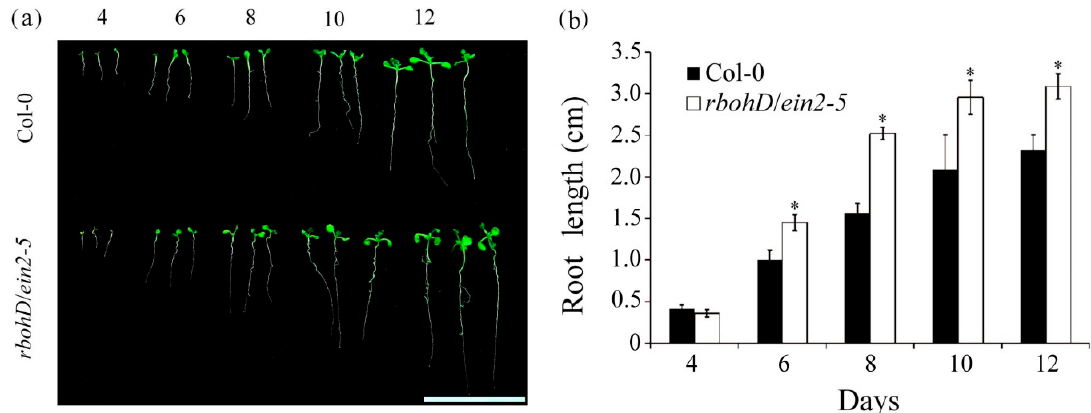
Figure3. Comparisonofrootgrowthinwild-typeand rbohD / ein2-5 doublemutantseedlings. ( a )Phenotypes Figure 3 . Comparison of root growth in wild ‐ type and rbohD / ein2 ‐ 5 double mutant seedlings. ( a ) of seedlings grown on 1 / 2 MS medium for 4, 6, 8, 10, and 12 d. Bar = 2 cm. ( b ) Average root length of Phenotypes of seedlings grown on 1/2 MS medium for 4, 6, 8, 10, and 12 d. Bar = 2 cm. ( b ) Average seedlings grown on 1 / 2 MS. Error bars represent SD of 100 seedlings of each genotype, obtained from three root length of seedlings grown on 1/2 MS. Error bars represent SD of 100 seedlings of each genotype, biologically independent experiments. * p < 0.05, versus wild-type (Student’s t obtained from three biologically independent experiments. * p < 0.05, versus wild ‐ type (Student’s t test).